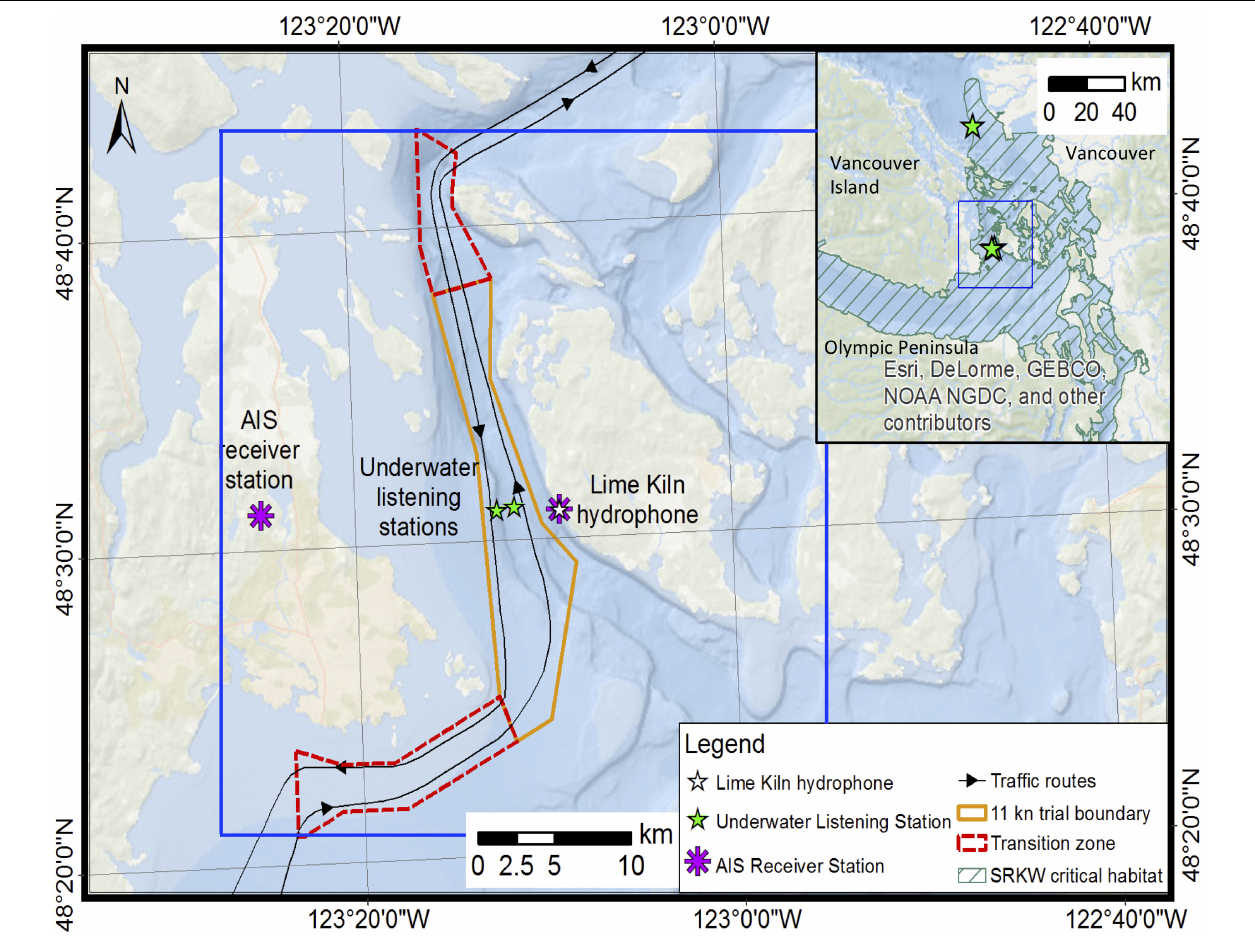
FIGURE 1 | Map of the Slowdown region. The two AIS receiver stations are shown as purple stars. The orange polygon depicts the 16 nm section of shipping lanes through which vessels were requested to slow to 11-knots speed-through-water. There are 4 underwater listening stations (ULS) as part of this study, three are within Haro Strait, two of which are located under the shipping lanes, and the third is cabled to shore and located at Lime Kiln Point on San Juan Island. The fourth ULS is in Georgia Strait, 30 km south of Vancouver, and shown only in the small map panel. The extent of the ‘regional vessel noise model’ for the ‘Slowdown region’ is depicted by the blue box, and includes cross-boundary waters of British Columbia, Canada and Washington State, United